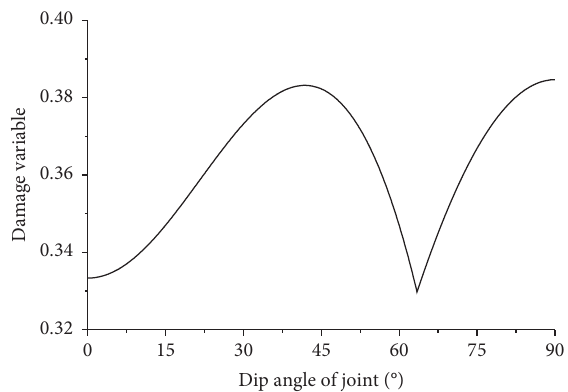
Figure 2: The change in the damage variable of coal body con- taining a joint with inclination angle of the